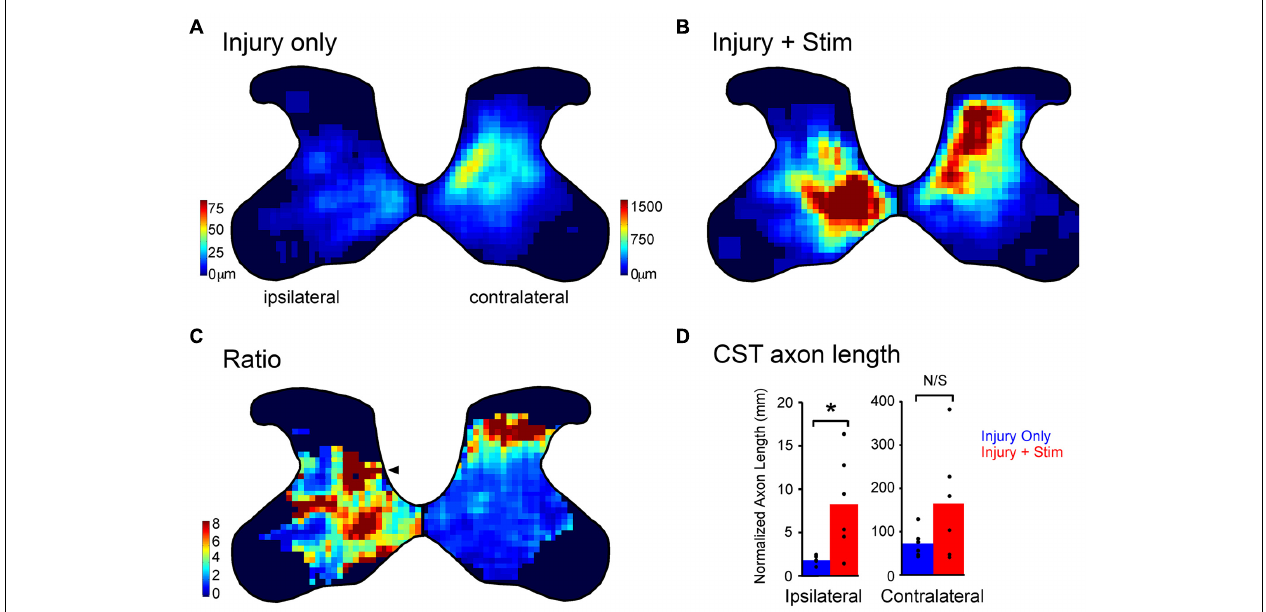
outgrowth is shown as the pixel-by-pixel ratio of injury and stimulation rats to injury only rats expressed as fold-change. The arrowhead indicates a hot spot of stimulation-induced outgrowth on the ipsilateral side in the deep dorsal horn. (D) Quantification of corticospinal axon length for the contralateral and ipsilateral sides ( ∗ p < 0.05). (A–D) were modified from Carmel etal.